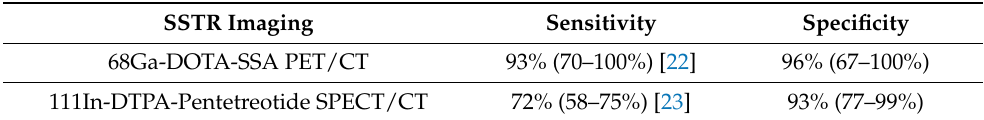
Table 1. Overall sensitivity and specificity comparing 111In-DTPA-Pentetreotide SPECT/CT and 68Ga-DOTA-SSA